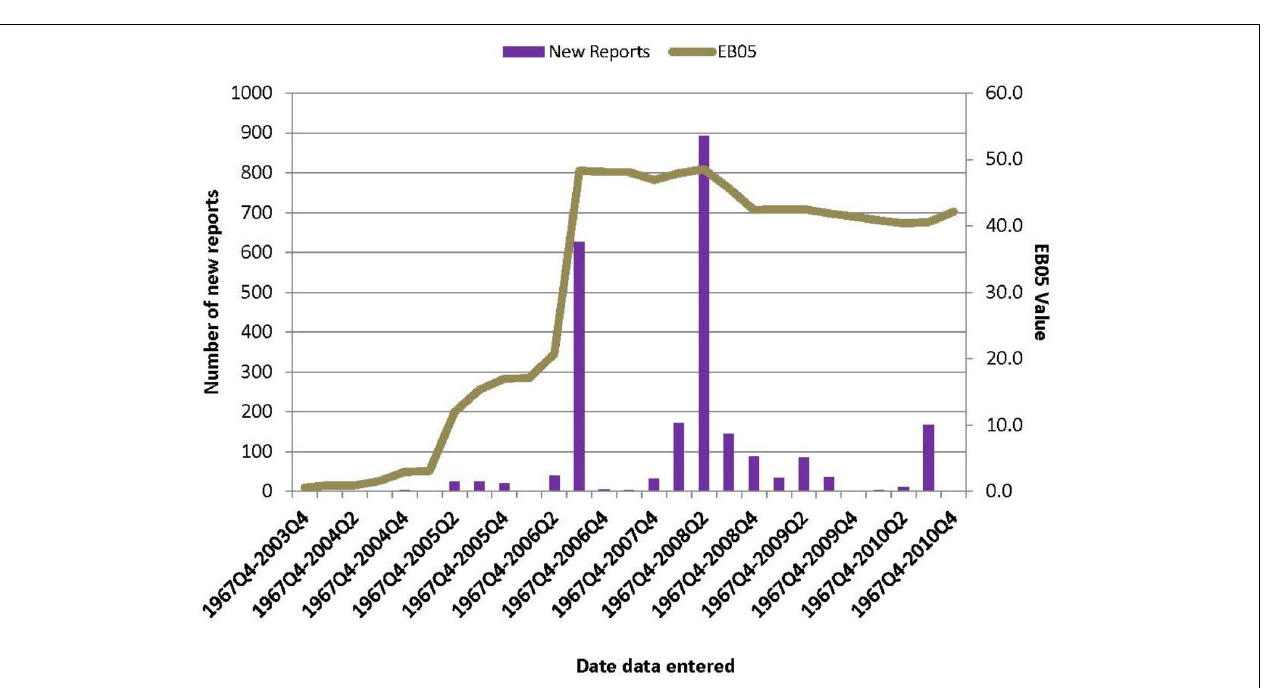
FIGURE 4 | Distribution of reports of AMI for which rofecoxib was the suspected drug as collected over time in the WHO- VigiBase spontaneous reporting database. EB05: Empirical Bayes posterior Gamma Mixture 5th percentile; estimates lower point in 90% confidence